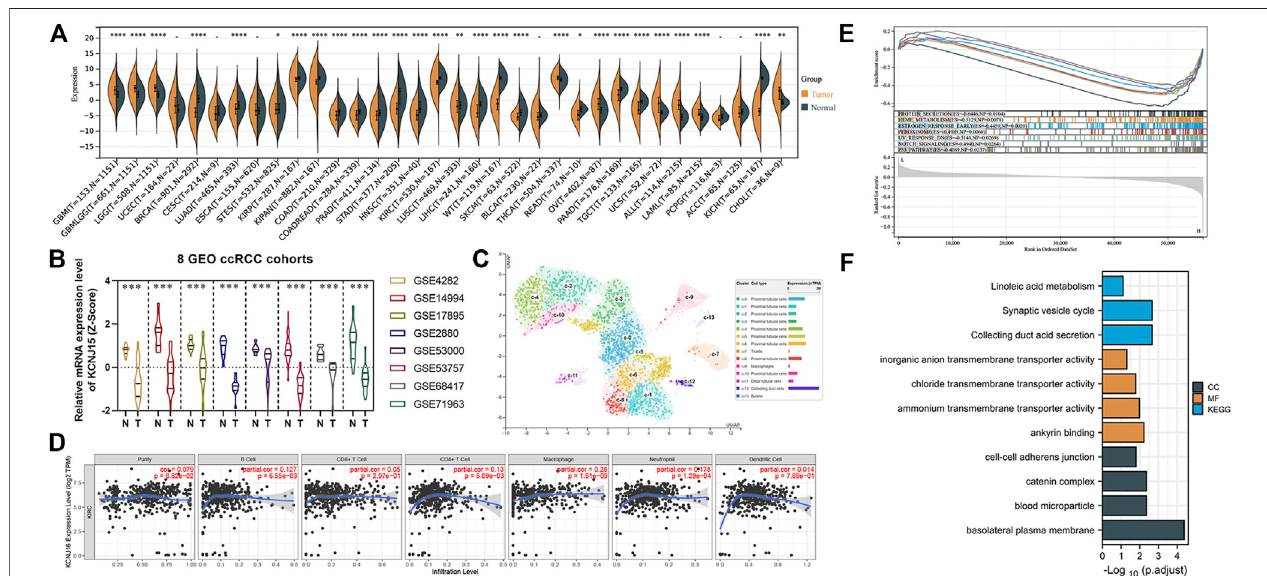
FIGURE 8 | Further exploration of the KCNJ16. (A) Pan-cancer analysis of the KCNJ16 mRNA expression among 33 types of cancers. (B) Analysis of eight GEO datasets regarding KCNJ16 expression in ccRCC and normal samples. (C) Single-cell analysis of the KCNJ16 expression in kidney tissues. (D) Association of the KCNJ16 expression level with immune in fi ltration abundance in ccRCC was evaluated using the TIMER database. (E) Multiple GSEA analysis on potential biological mechanisms between low- and high-risk groups. (F) GO and KEGG enrichment analyses between high- and low-risk groups.